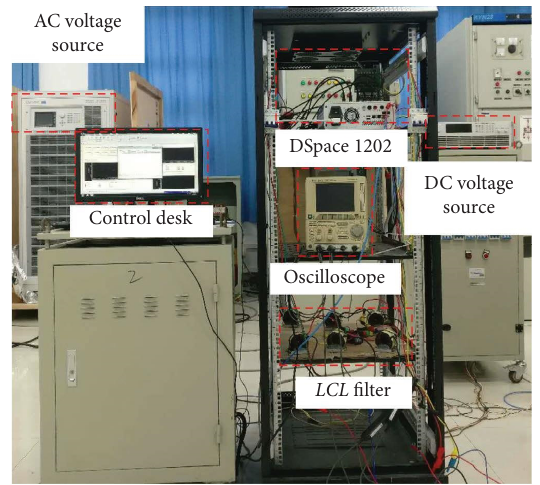
Figure 13: Experimental system prototype.